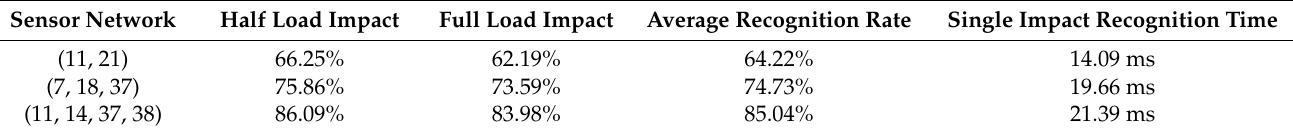
Table 6. Impact recognition rate of different sensor networks.